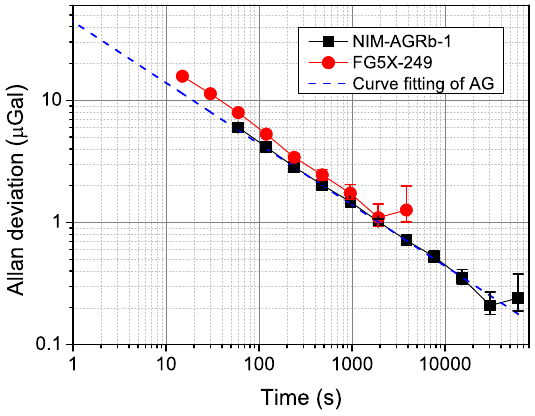
Figure 13. Allan deviations of NIM-AGRb-1 and FG5X-249.